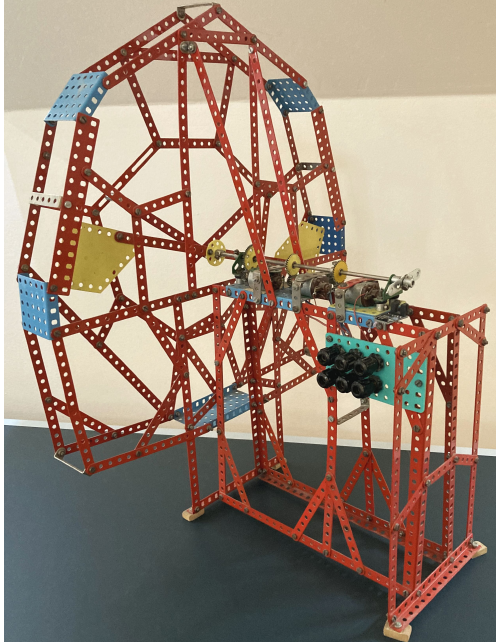
Figure 1. The considered electro-mechanical speed